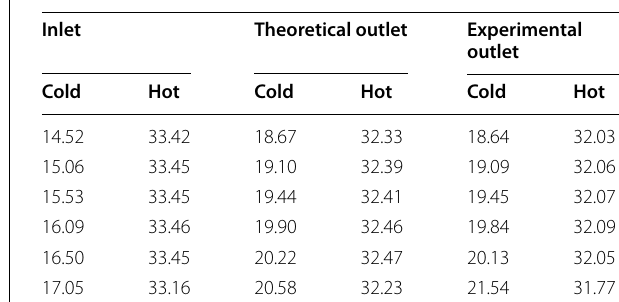
Table 2 Inlet and outlet temperatures (°C)